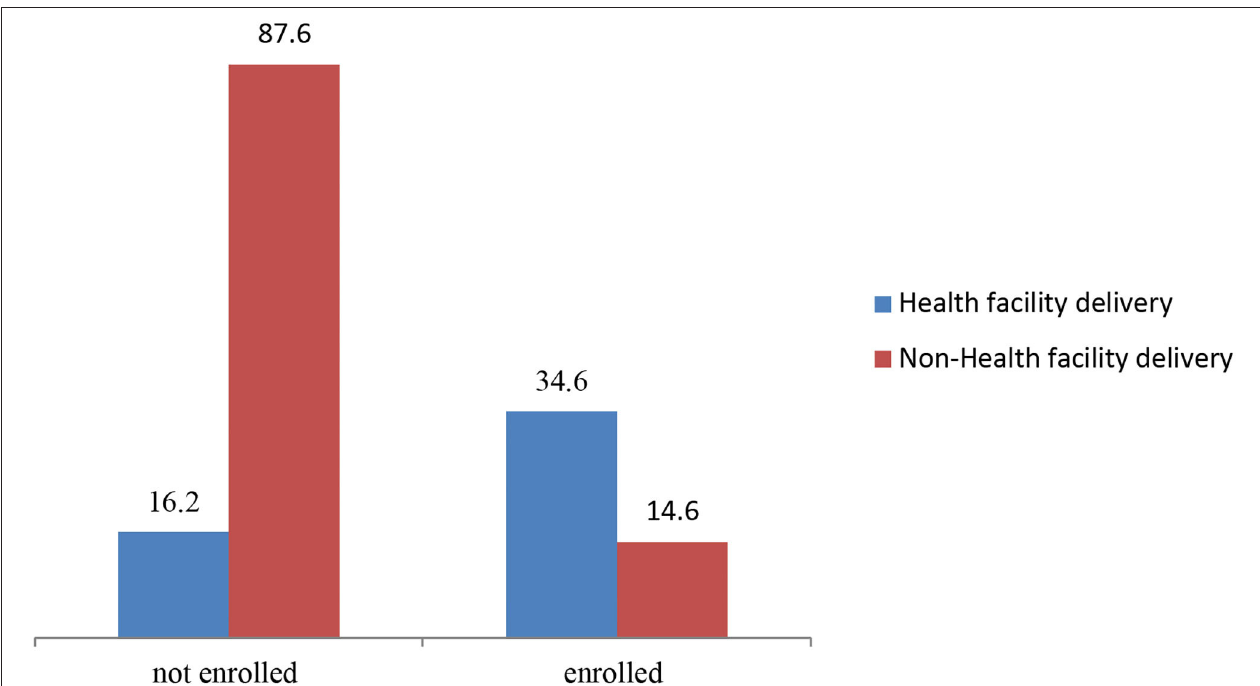
FIGURE 1 | The proportion of women who delivered in health facility across those who enrolled and those who did not enroll in health insurance. Source: Authors’.